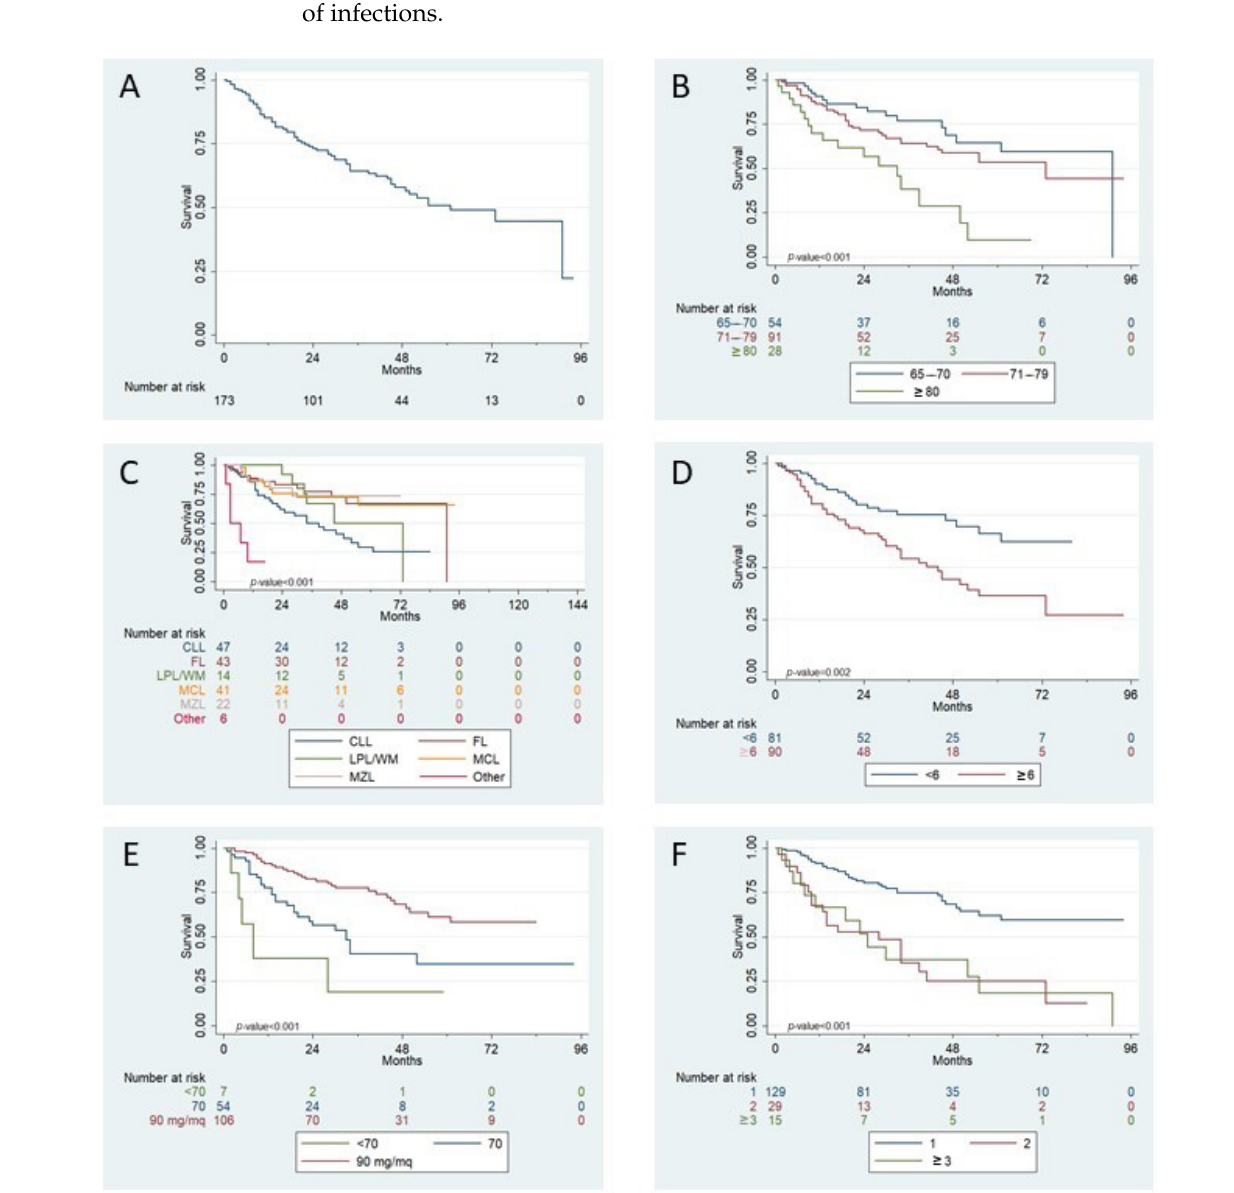
Figure 4. Univariate analysis for TTP. Panel ( A ): median TTP after bendamustine-based treatment initiation, overall series; panel ( B ): TTP according to different age classes; panel ( C ): TTP stratified by initial histological diagnosis; panel ( D ): TTP according to CIRS score at bendamustine administration; panel ( E ): effect of bendamustine dose received on TTP; panel ( F ): TTP stratified according to line of therapy at bendamustine